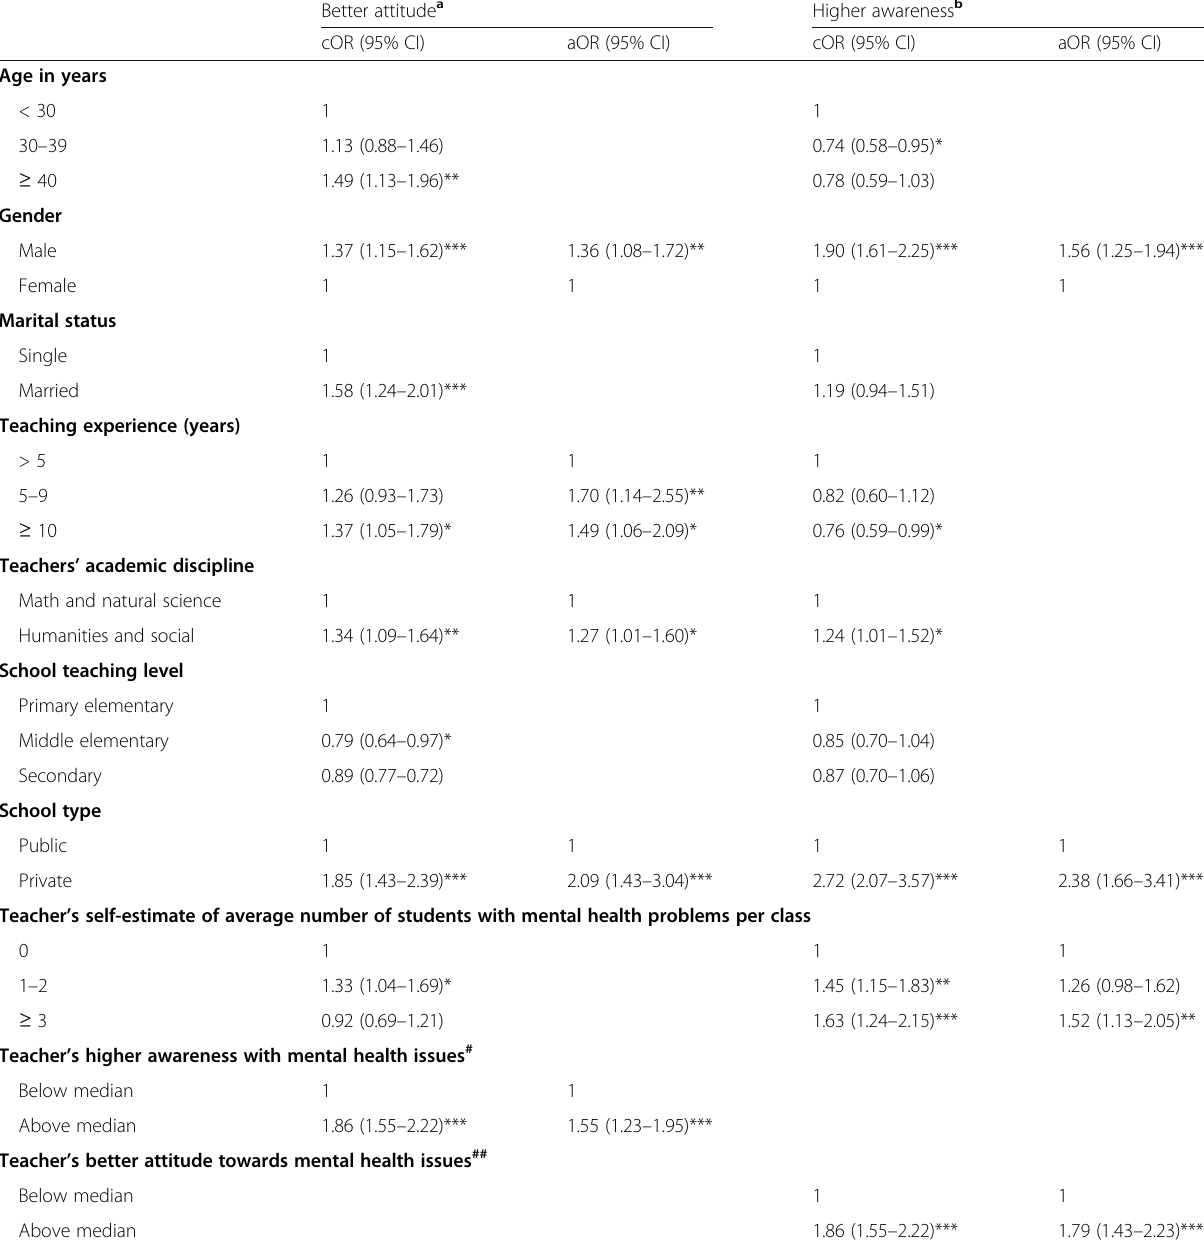
Table 4 Logistic regression analyses for teachers ’ background information and school characteristics associated with better attitude and higher awareness about mental health issues in